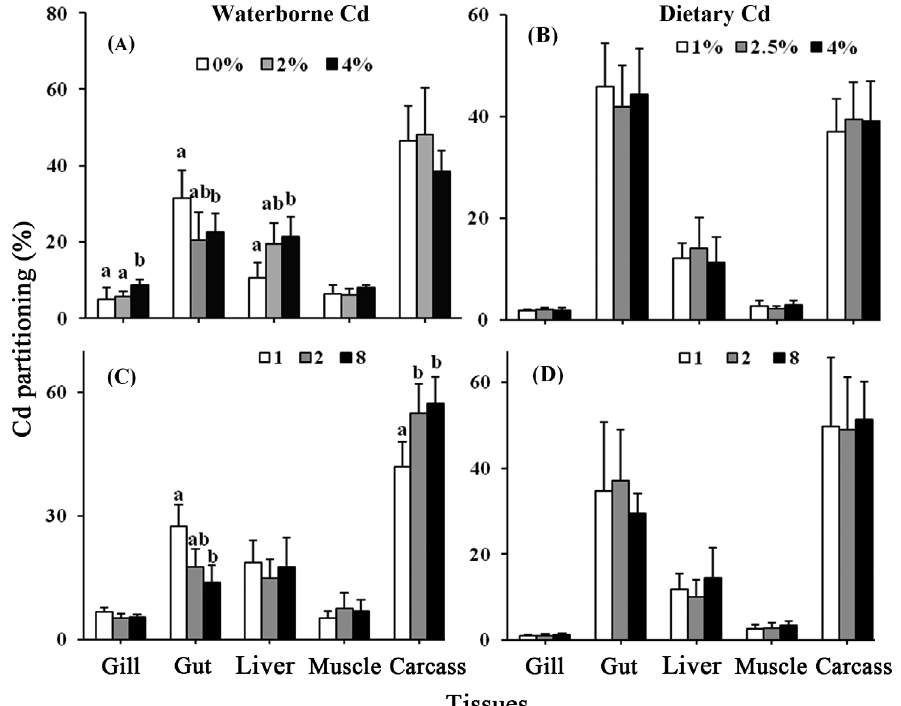
Fig. 3. Cadmium partitioning (%) among the gills, gut, liver, muscle and carcass of black sea bream Acanthopagrus schlegeli under 5 wk exposure of waterborne or dietary Cd at 3 different levels of feeding ratio (FR) or frequency (FF). FR treatments: fish were fed (A) 0, 2 and 4% body weight (BW) d –1 under waterborne exposure or (B) 1, 2.5 and 4% BW d –1 under dietary exposure. FF was 2 times d –1 . FF treatments: fish were fed 1, 2 and 8 times d –1 at a FR of 3% BW d –1 under (C) waterborne or (D) dietary exposure. Mean ± SD, n = 6 (3 fish per replicate tank); means of the same tissue with different superscripts are significantly different among treatments (p <